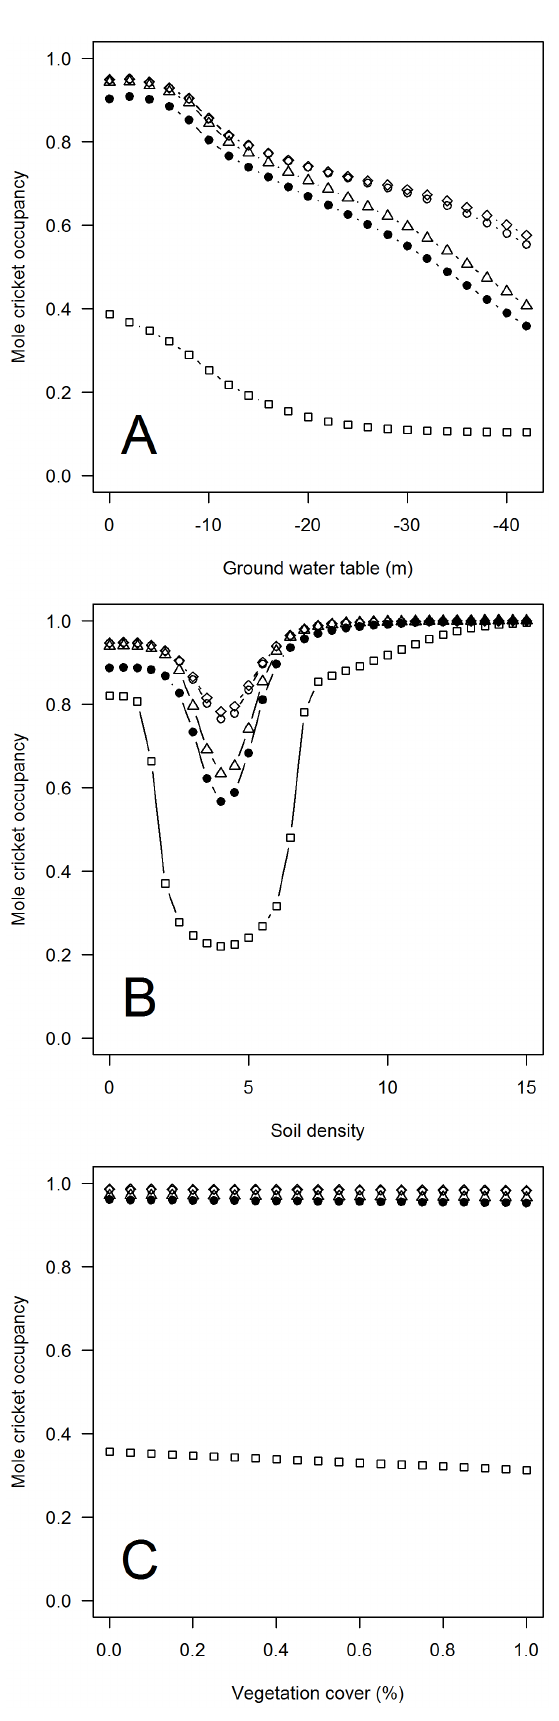
Figure 3. Occupancy probability of mole crickets in response to key habitat properties. Occupancy probability of mole crickets in response to a) depth of the ground water table, b) soil density, and c) surface vegetation cover. Model-averaged predictions are shown for five different soil types occurring at the sampling sites (Table 1). Closed circles represent soil type 1, open circles represent soil type 2, open squares represent soil type 3, open diamonds represent soil type 4 and open triangles represent soil type 5 (see Table 1 for the description of soil